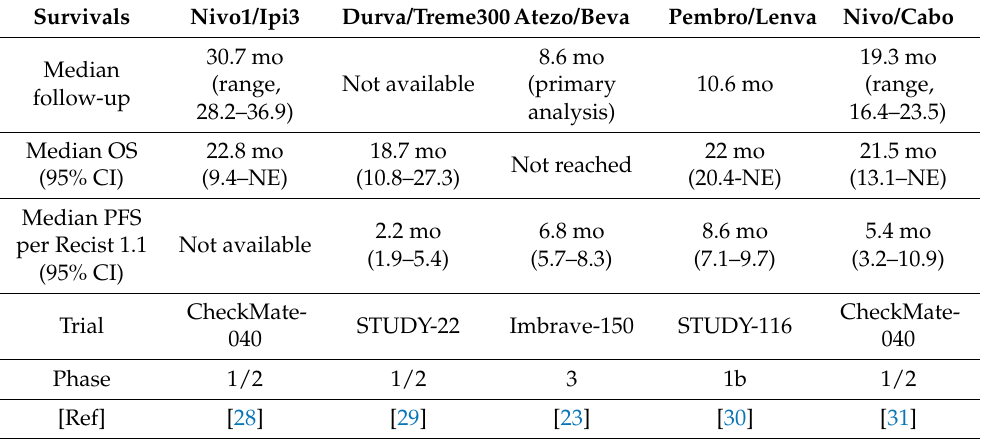
Table 2. Summary of survival parameters in the immuno-oncology-based combination trials.